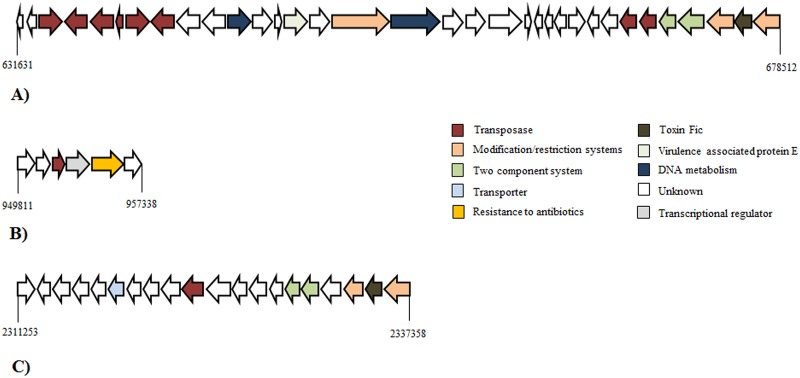
Schematic representation of Genomic islands (GI) present in the F. psychrophilum isolates.A) GI found in F. psychrophilum CSF 259–93 associated with toxin Fic and virulence factor E family. B) GI found in F. psychrophilum CSF 259–93 associated with tetracycline resistance. C) GI found in F. psychrophilum 950106-1/1 associated with toxin Fic. The colors were assigned according to the possible role of each ORF.